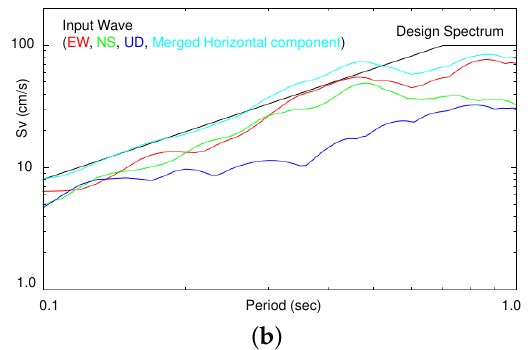
Figure 4. Input ground motion. Here the wave observed in the target area during the 2011 Tohoku earthquake (observation point S14, SAKR of Small Titan [27]) is pulled back to the bottom of the model and used as the input wave. Velocity response spectrum of design wave of pipeline is also